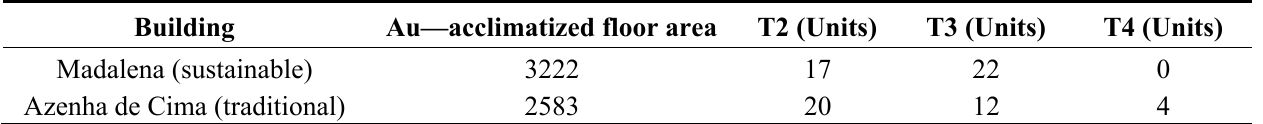
Table 3. Description of type of dwelling and acclimatized area—Madalena vs . Azenha de Cima. Building